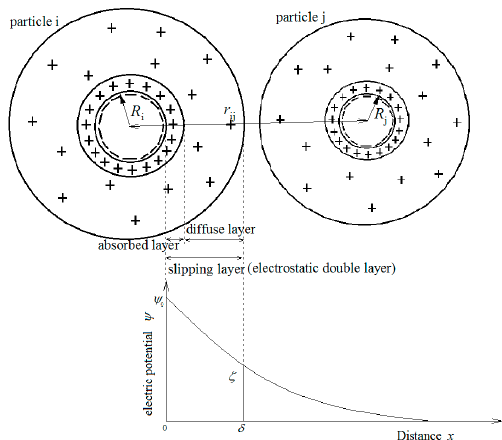
Figure 3. Illustration of slipping layer thickness, equaling the thickness of the electrostatic double layer in Yang et al.’s study [37]. This zone is comprised of an absorbed layer and a diffuse layer. The slipping layer thickness can be calculated by the potentials ψ 0 on the particle surface and ζ at the distance δ as the potential decays exponentially. When the particles are close enough and wrapped by a common slipping layer, they are considered as forming a new or enlarging an old floc.